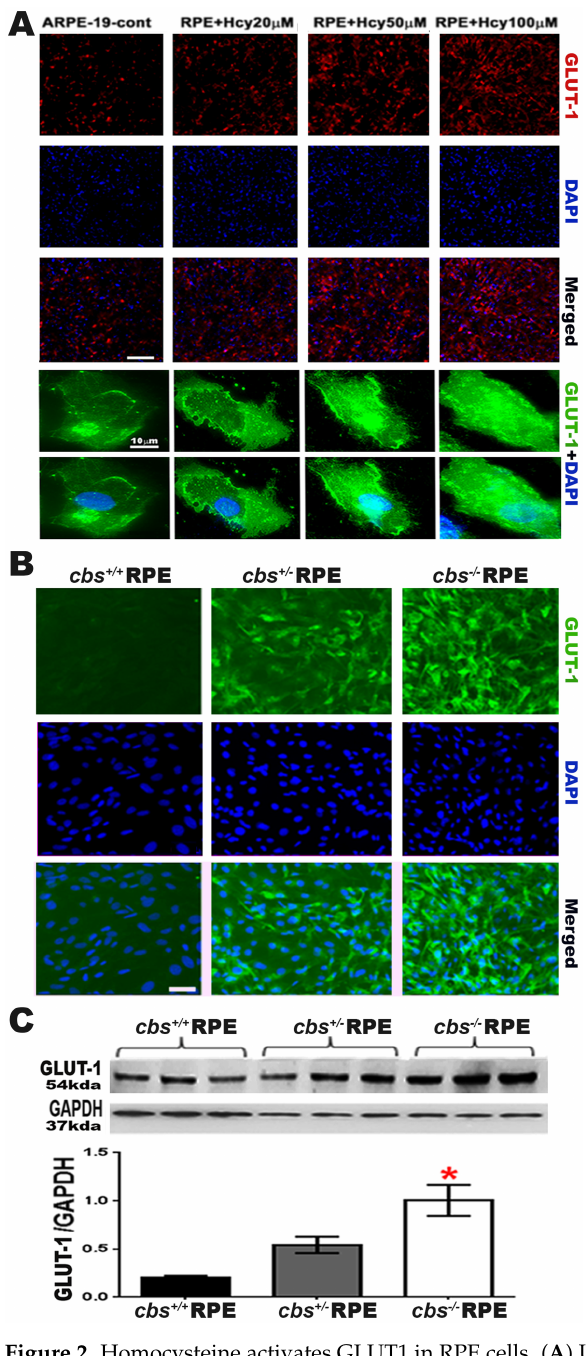
Figure 2. Homocysteine activates GLUT1 in RPE cells. ( A ) Upper part: immunofluorescence staining for GLUT1 in ARPE-19 (red) treated with different concentrations of Hcy (20, 50, and 100 µ M). High magnification image showing that Hcy significantly increased GLUT1 expression in ARPE cells in a dose-dependent manner. Lower part: high magnification image immunofluorescence staining for GLUT1 in ARPE-19 (green) treated with different concentrations of Hcy (20, 50, and 100 µ M). ( B ) Immunofluorescence staining for GLUT1 in primary RPE cells isolated from wild-type cbs +/+ , cbs +/ − and cbs − / − mice (green) with nuclear staining (DAPI, blue). ( C ) Western blot of GLUT1 expression in primary RPE cells isolated from cbs +/+ , cbs +/ − and cbs − / − mice. GADPH was used as a loading control * p < 0.05 as compared to WT-RPE and cbs +/ − mice. The data show that Hcy significantly increased GLUT1 expression of RPE cells both in vivo and ex-vivo. Scale bar: 50 µ m (A upper part &B) and 10 µ m (A lower part). * p < 0.05 compared to cbs +/+ and cbs +/ −